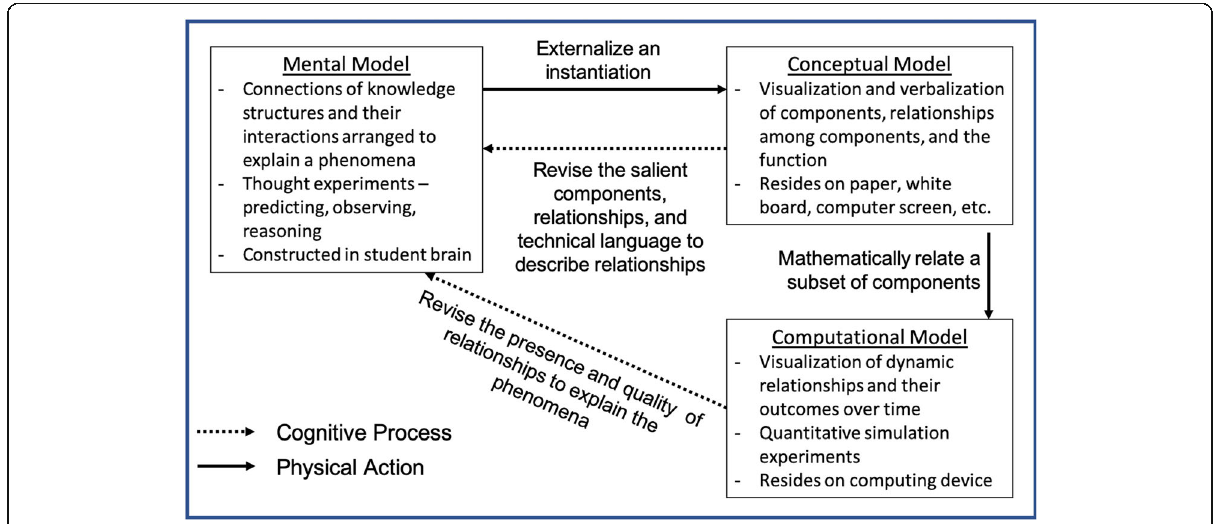
Fig. 1 Biological phenomena are complex interactions of system structures and can be represented by models (boxes) of the structures, relationships, and dynamics that reside in different spaces. There are physical actions (solid arrows) that externalize and mathematize mental and conceptual models and cognitive processes (dotted arrows) that feedback to the student ’ s mental model of the biological